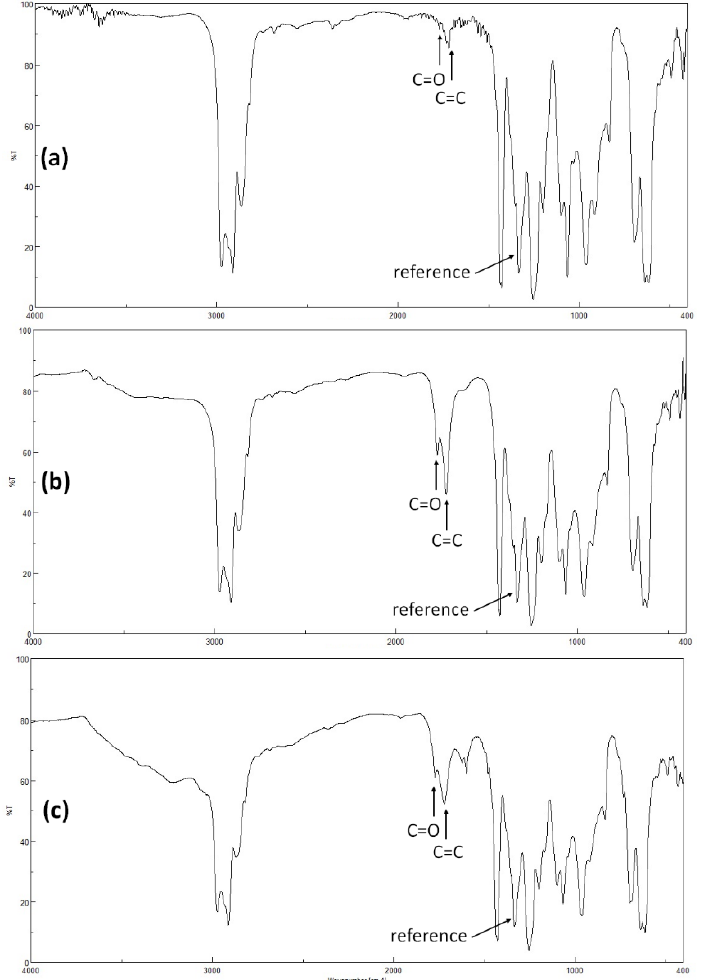
Figure 2. Fourier-transform infrared (FTIR) spectra of ( a ) poly(vinyl chloride) (PVC) before irradia- tion, ( b ) PVC after irradiation, and ( c ) PVC + 1 after irradiation.